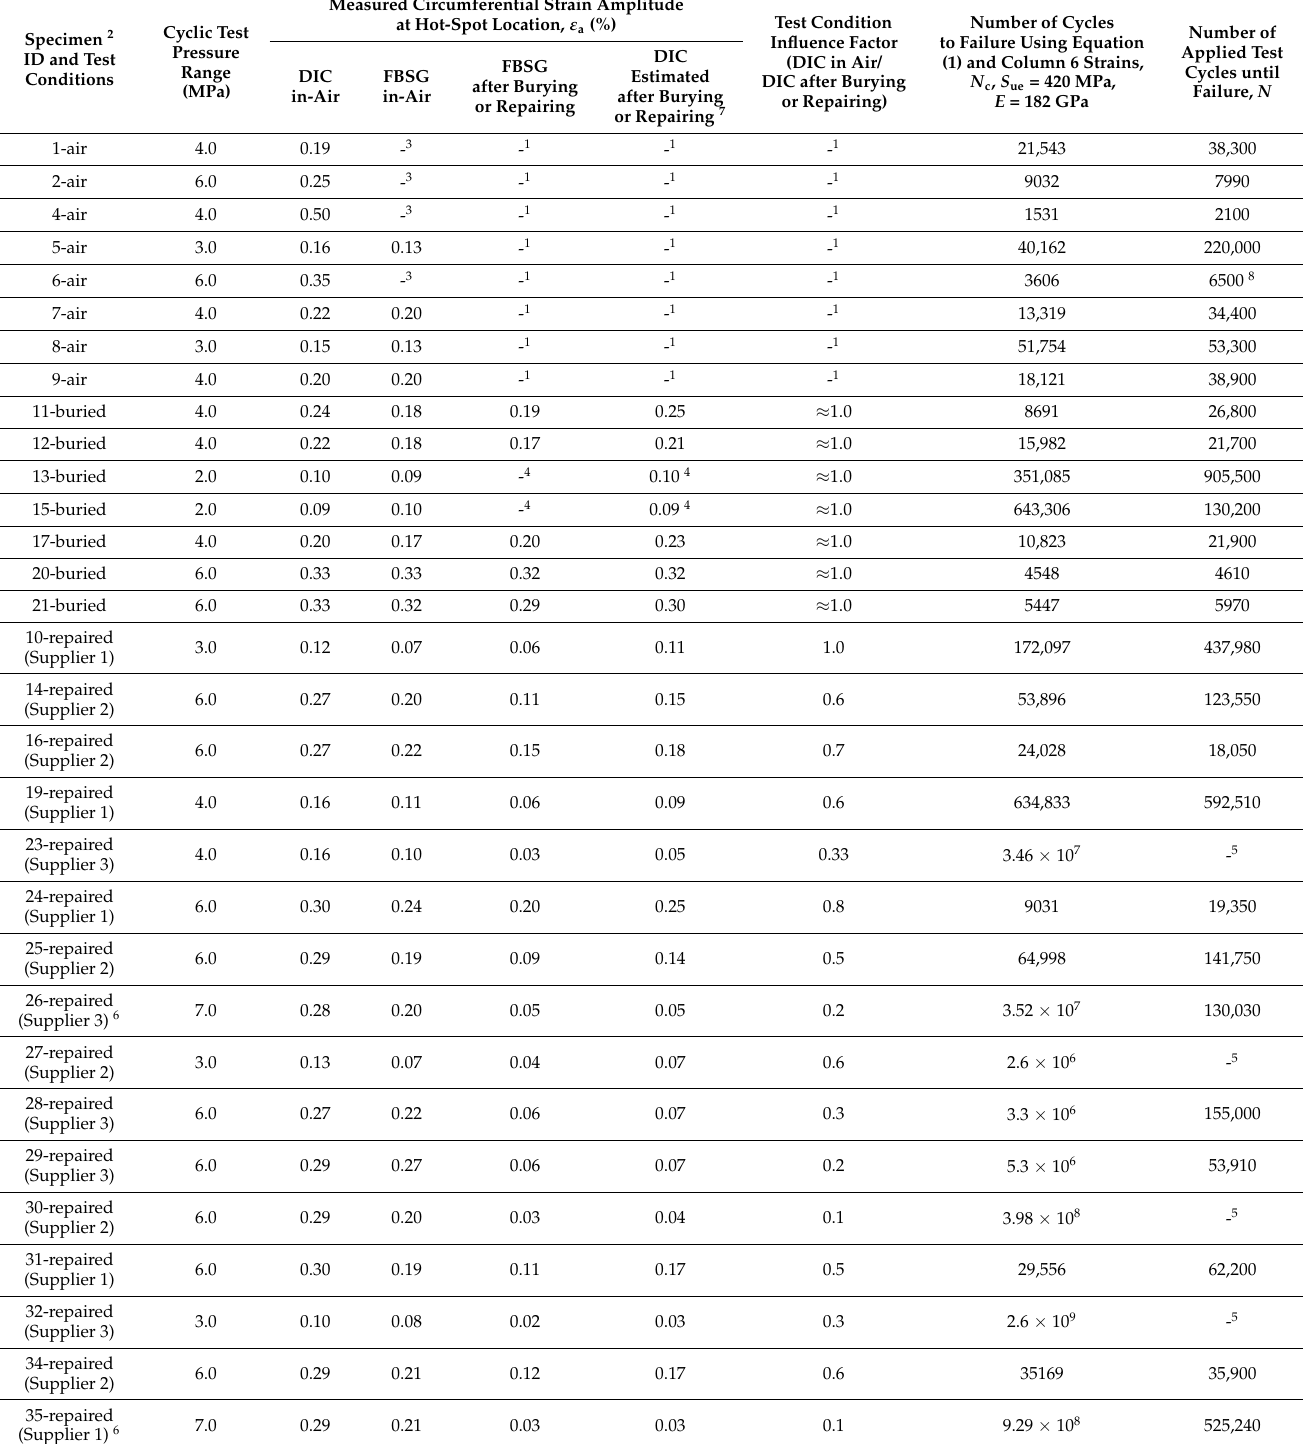
Table 1. Experimental